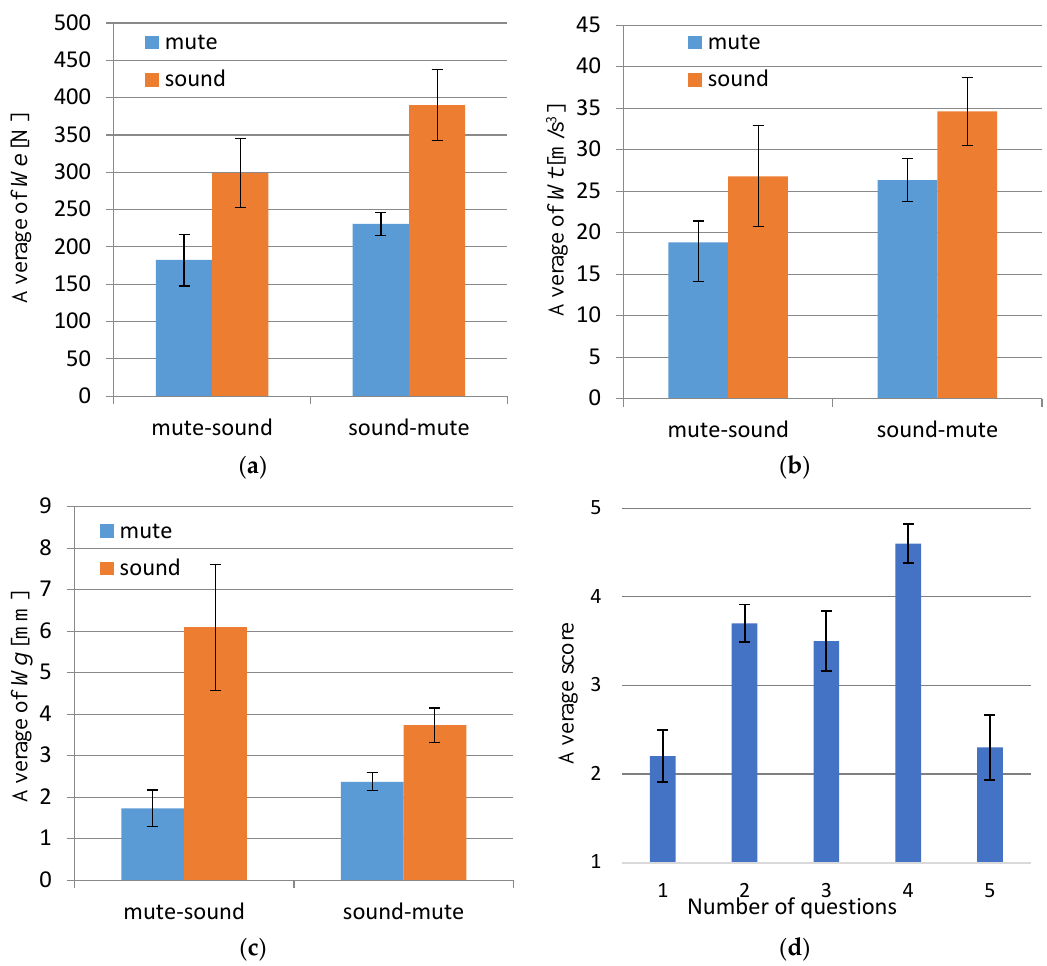
Figure 8. Experimental results. Mute-sound denotes condition “mute” followed by condition “sound”; sound-mute denotes condition “sound” followed by condition “mute”: ( a ) Result of We ; ( b ) Result of Wt ; ( c ) Result of Wg; ( d ) Questionnaire results—average score of five (positive) to one (negative).